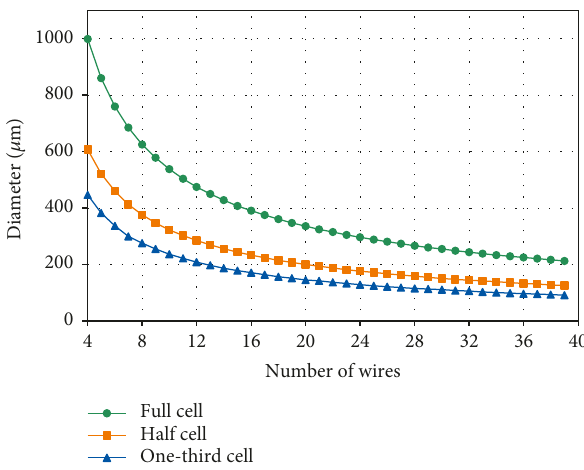
Figure 11: Relationship between the optimized wire diameters and the wire numbers for hull-, half-, and one-third-cell